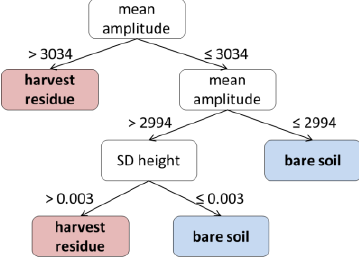
Figure 2. Polynomial function (degree 9) of range-amplitude dependency assessed by least square fitting to moving median values of original amplitude of laboratory experiment (cf. Höfle, 2013).